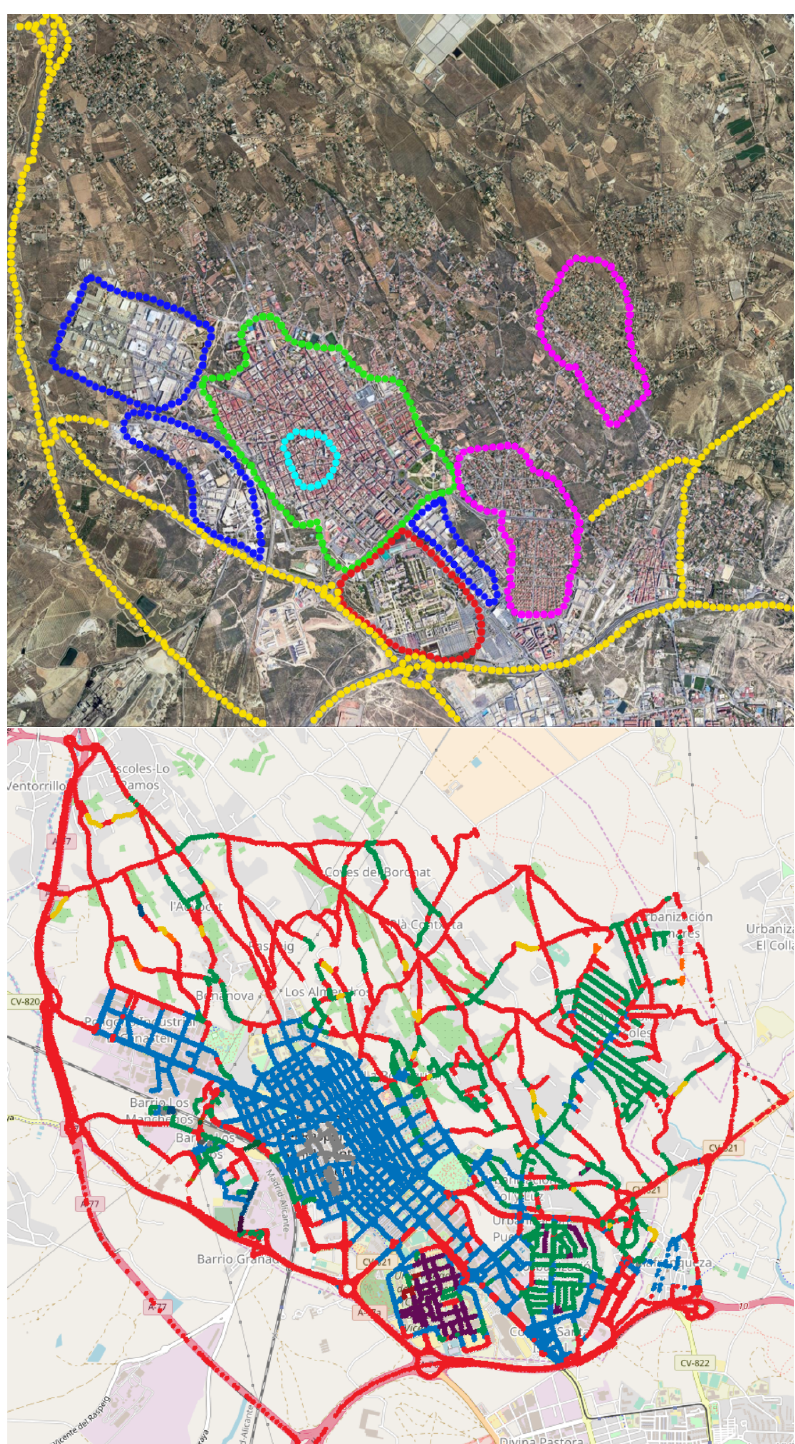
Figure 24. Comparison of results with the ground truth ( top ) and the smoothed map ( bottom